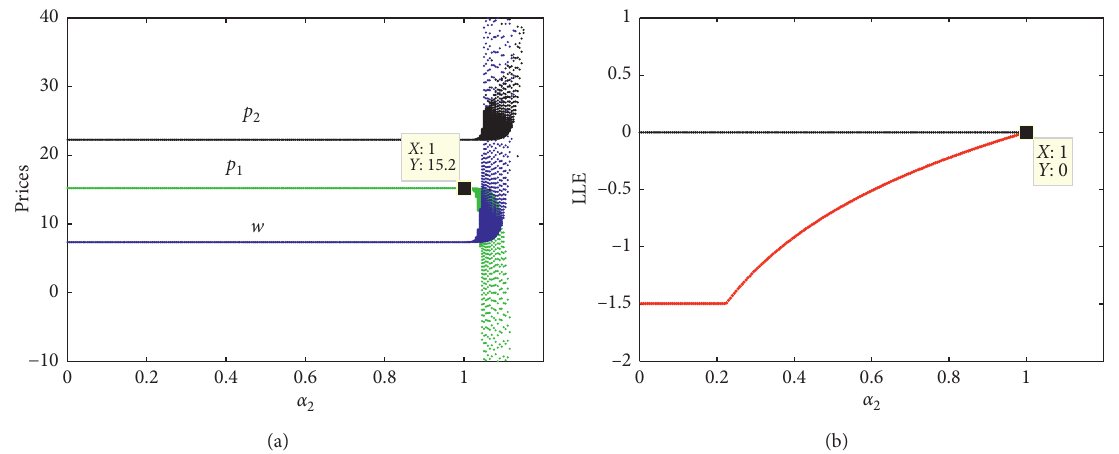
Figure 4: The behavior of dynamic system (9) with respect to α